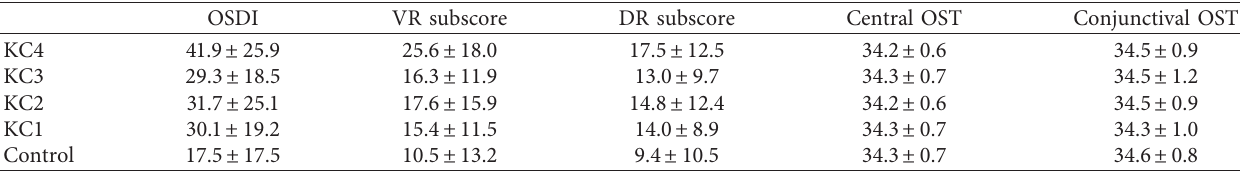
Table 3: Ocular Surface Disease Index (OSDI) score and subscores and central and conjunctival ocular surface temperature (OST) in different stages of keratoconus (KC) and controls.